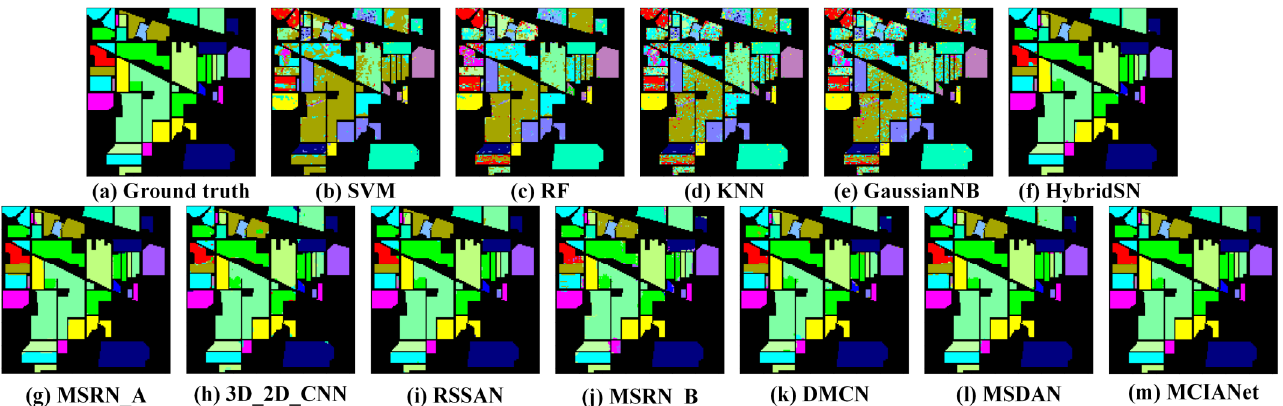
Figure 4. The classification visual maps on BOW dataset.